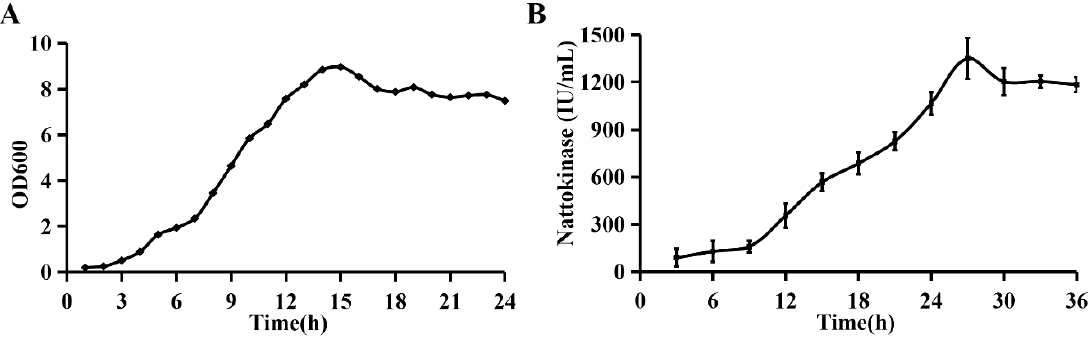
Figure 5. Determination of the growth curve and nattokinase (NK) yield at different growth stages of WTC016. ( A ) The growth curve of WTC016 and ( B ) the dynamic of NK production throughout the cultivation of WTC016 in liquid Luria-Bertani (LB) medium.